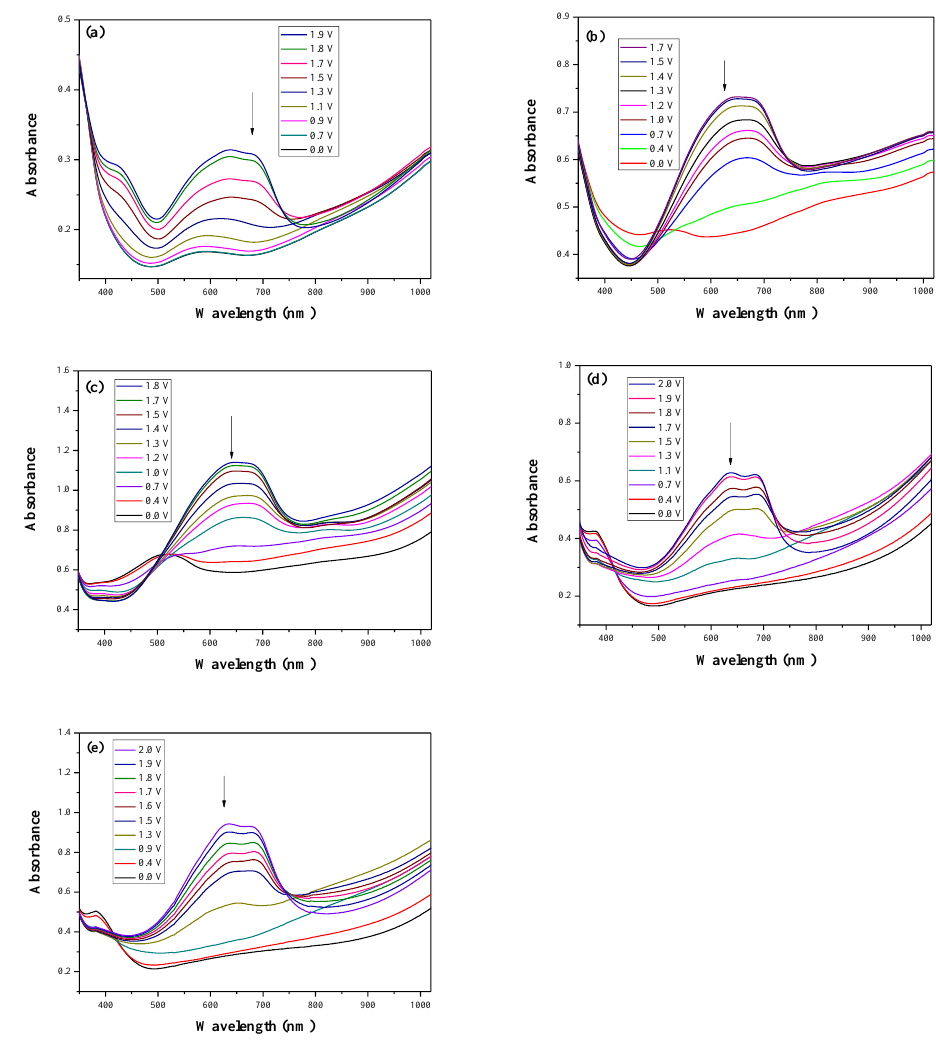
Figure 7. UV – VIS spectra of ( a ) PDiCP/PEDOT-PSS; ( b ) P(DiCP- co -CPDT)/PEDOT-PSS; ( c ) P(DiCP- co -CPDT2)/PEDOT-PSS; ( d ) P(DiCP- co -CPDTK)/PEDOT-PSS; and ( e ) P(DiCP- co -CPDTK2)/PEDOT-PSS ECDs. Table 5. Electrochromic photographs, colourimetric values ( L *, a *, and b *), CIE chromaticity values ( x , y ), and CIE diagram of P(DiCP- co -CPDTK)/PEDOT-PSS ECD at various applied potentials. Potential (V)